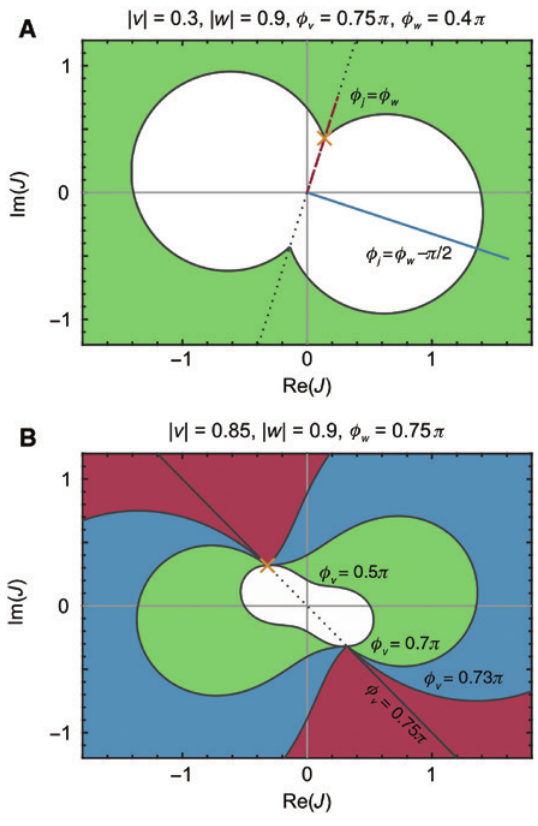
Figure 5: Bulk edge correspondence phase diagrams constructed using bulk and edge eigenvalues for the non-Hermitian NNN SSH model. (A) The BEC phase diagram with predicted region of BEC (white) and its breakdown (green) for parameters of the chain from Figure 4, with φ from Figure 4A (red dashed line) and Figure 4B (blue J line), yellow cross at w /2 and dotted line along φ . (B) The BEC w phase diagrams for | v | ≈ | w | and varying φ . The red, blue and green v colorings represent different regions where the BEC breakdown = 0.73 π , red and occurs for different choices of φ , with red for φ v v = 0.7 π , and finally all of red, blue and green for φ = 0.5 π blue for φ v v origin with | J | = 0 and moves in a straight line away as the chirality breaking parameter | J | increases, the edge modes and bulk meet when we cross the black line from the white region to the green region. Therefore, the white region cor- responds to the values of J with BEC and the green region corresponds to values where it is broken. The red dashed and blue solid lines correspond to choices of φ from J Figure 4B and C, respectively. We can see that for Figure 4B, the bulk bands are shifted directly towards | E | = 0, whereas in Figure 4C they do not move towards | E | = 0, so that the slower movement of the edge modes causes BEC break- down. This illustrates that breakdown occurs for different degrees of chiral symmetry breaking, | J |, depending on the direction the bands are shifted due to choice of parameter φ . For | v | << | w |, as in Figure 5A, the phase corresponding J